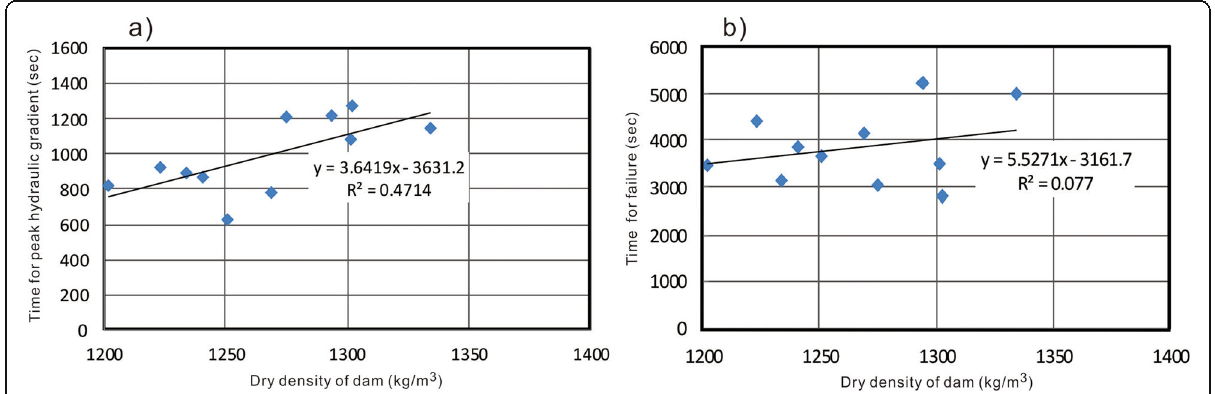
Fig. 3 Effects of density on ( a ) time for initial peak hydraulic gradient and ( b ) time for failure of dam crest